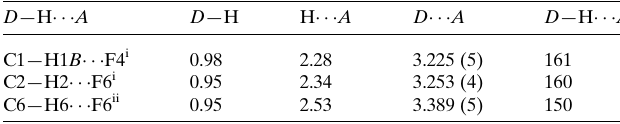
Table 2 Hydrogen-bond geometry (A˚ , (cid:4) ) for 2 .